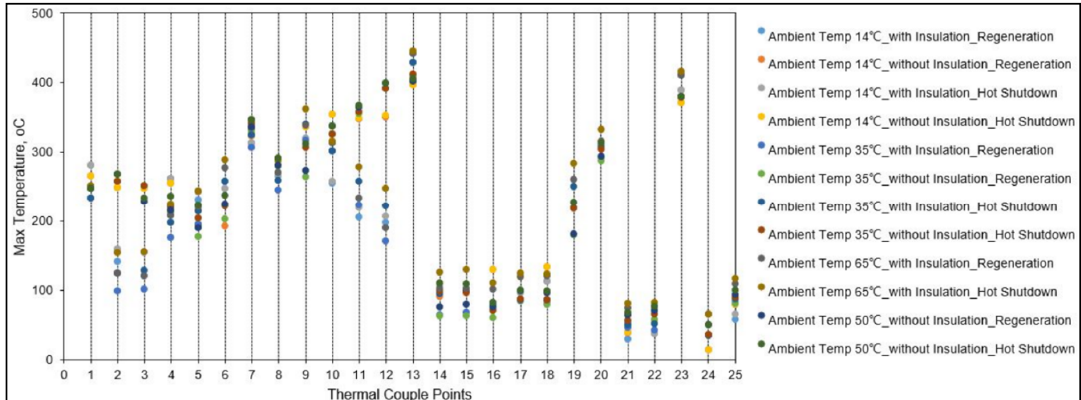
Figure 5. All measured temperatures scatter